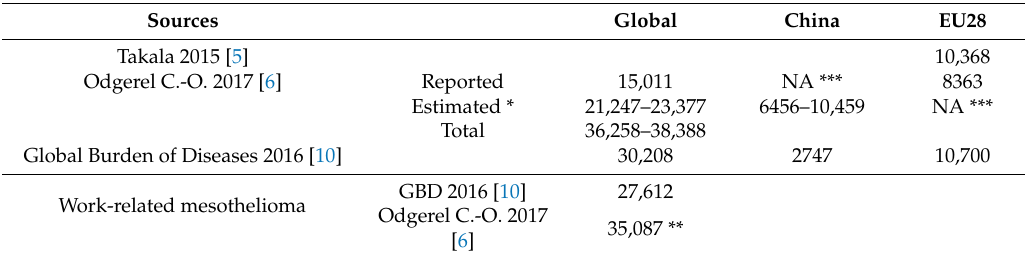
Table 1. Summary of most recent information related to mesothelioma.